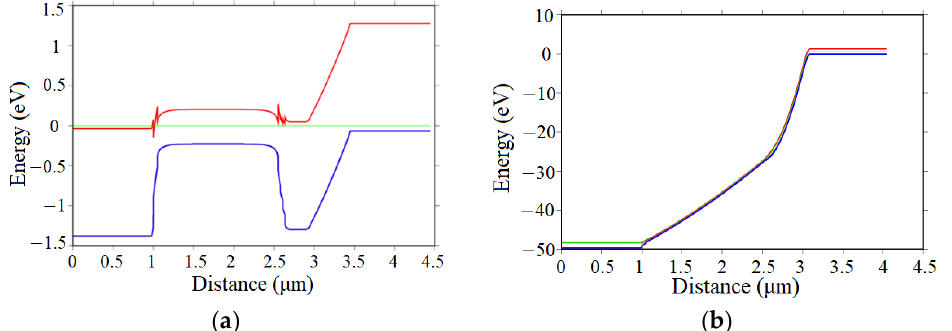
Figure 2. Energy band structure of the 5-nm-In 0.53 Ga 0.47 As/5nm-GaAs 0.51 Sb 0.49 superlattice material. Figure 3. Calculated energy band structure of the SAGCM APD device with equivalent material method. ( a ) at equilibrium; ( b ) at breakdown